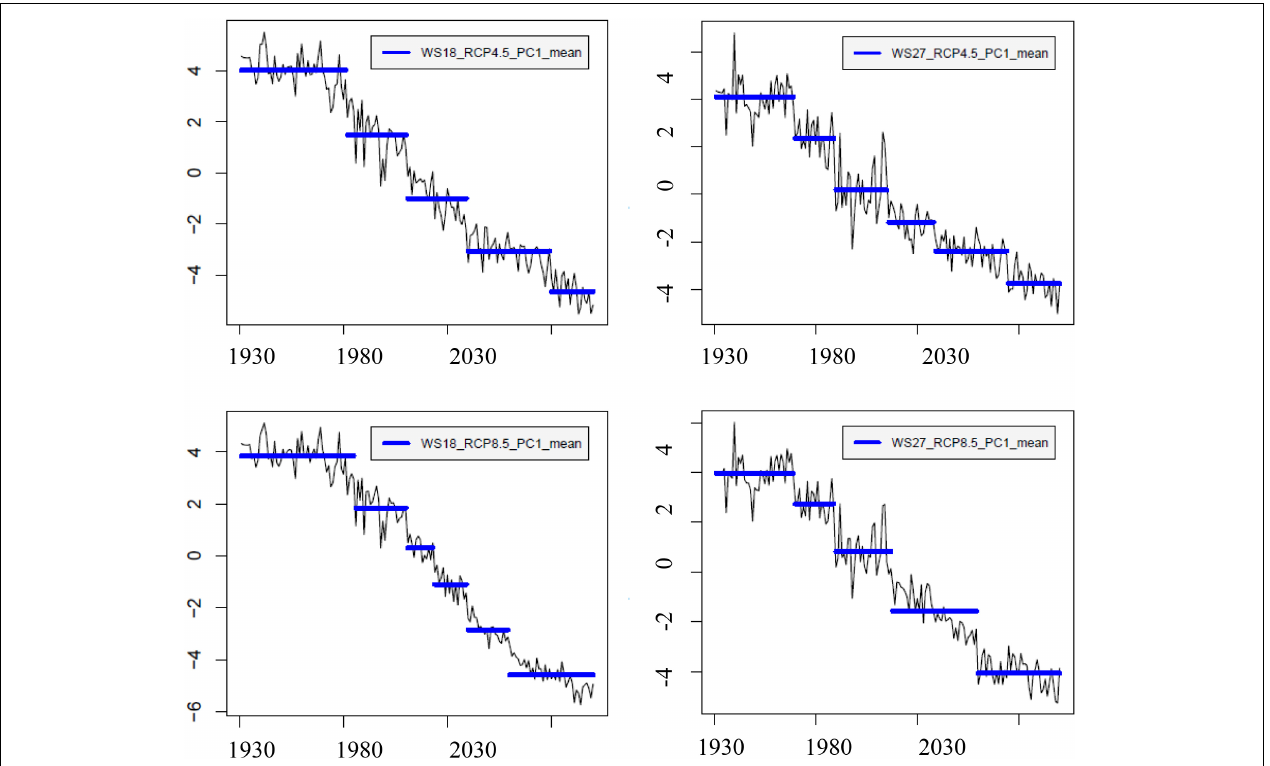
FIGURE 8 | Change points of the first principle component of the simulated biogeochemical variables at WS18 and WS27 ( top left – WS18 RCP4.5, bottom left – WS18 RCP8.5, top right – WS27 RCP4.5, and bottom right – WS27